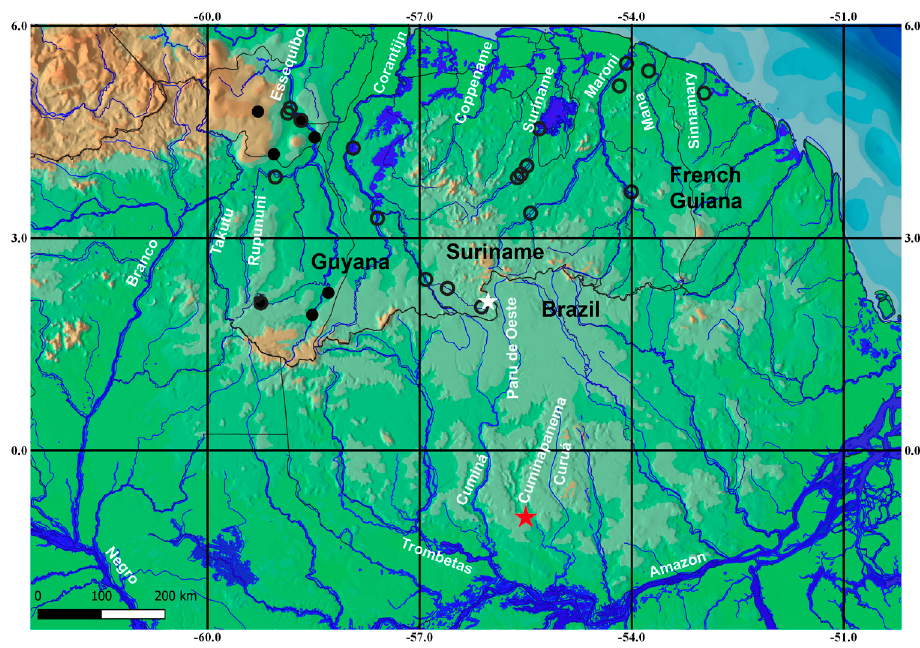
FIGURE 1 | Distribution of Cteniloricaria in the Guiana Shield. Circles = C. platystoma according to Covain et al . (2012); black dots = C. platystoma , examined specimens. White star, type locality of C. napova ; red star, new locality of C. napova . Each symbol can cover more than one lot or locality.